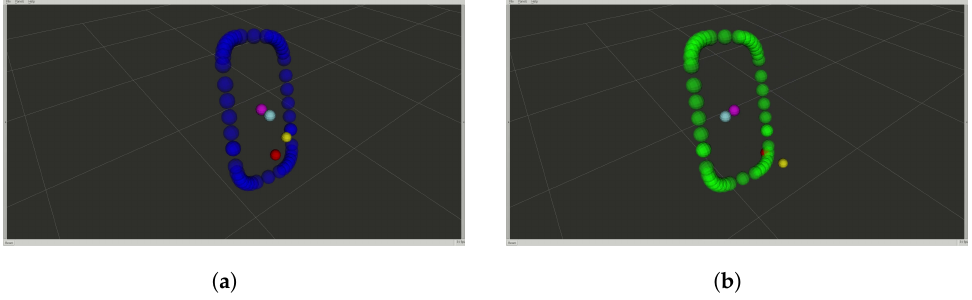
Figure 2. Conventional PC-based user interface: visual references and effects. ( a ) Video: 0 m 20 s. ( b ) Video: 0 m 23 s.